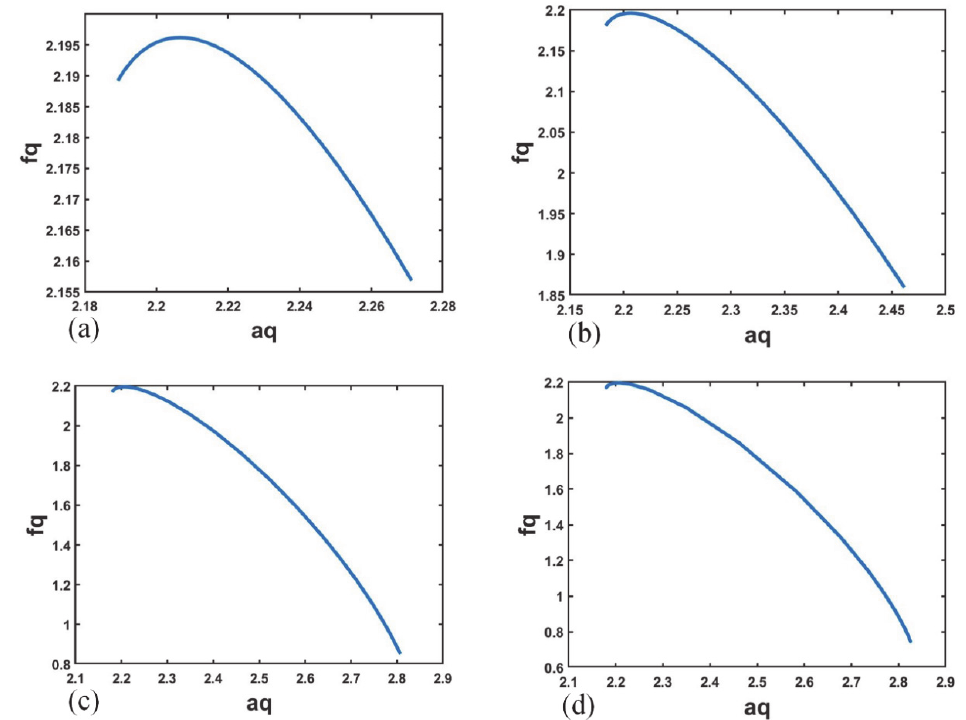
Figure 4. Multifractal spectrum images with different q values: ( a ) q ∈ [ − 1, 1 ] . ( b ) q ∈ [ − 2, 2 ] . ( c ) q ∈ [ − 5, 5 ] . ( d ) q ∈ [ − 10, 10 ] .